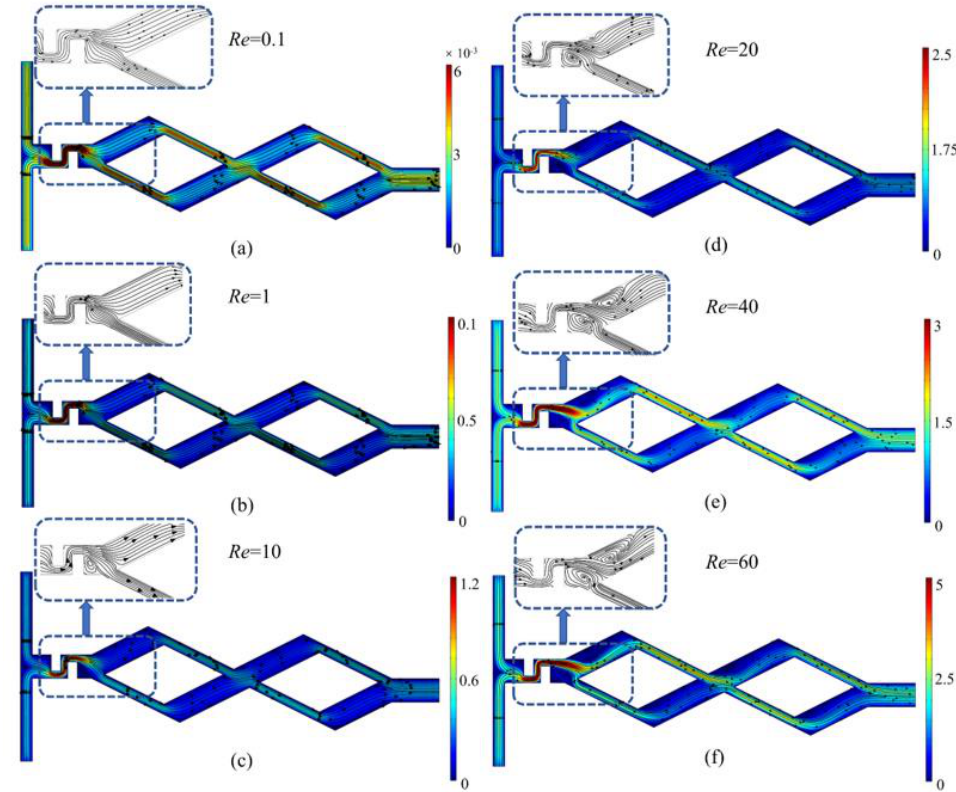
Figure 6. Velocity field distribution (m/s) of asymmetric rhombus micromixer with baffles at Re = 0.1, 1, 10, 20, 40 and 60. ( a ) Re = 0.1; ( b ) Re = 1; ( c ) Re = 10; ( d ) Re = 20; ( e ) Re = 40; ( f ) Re =